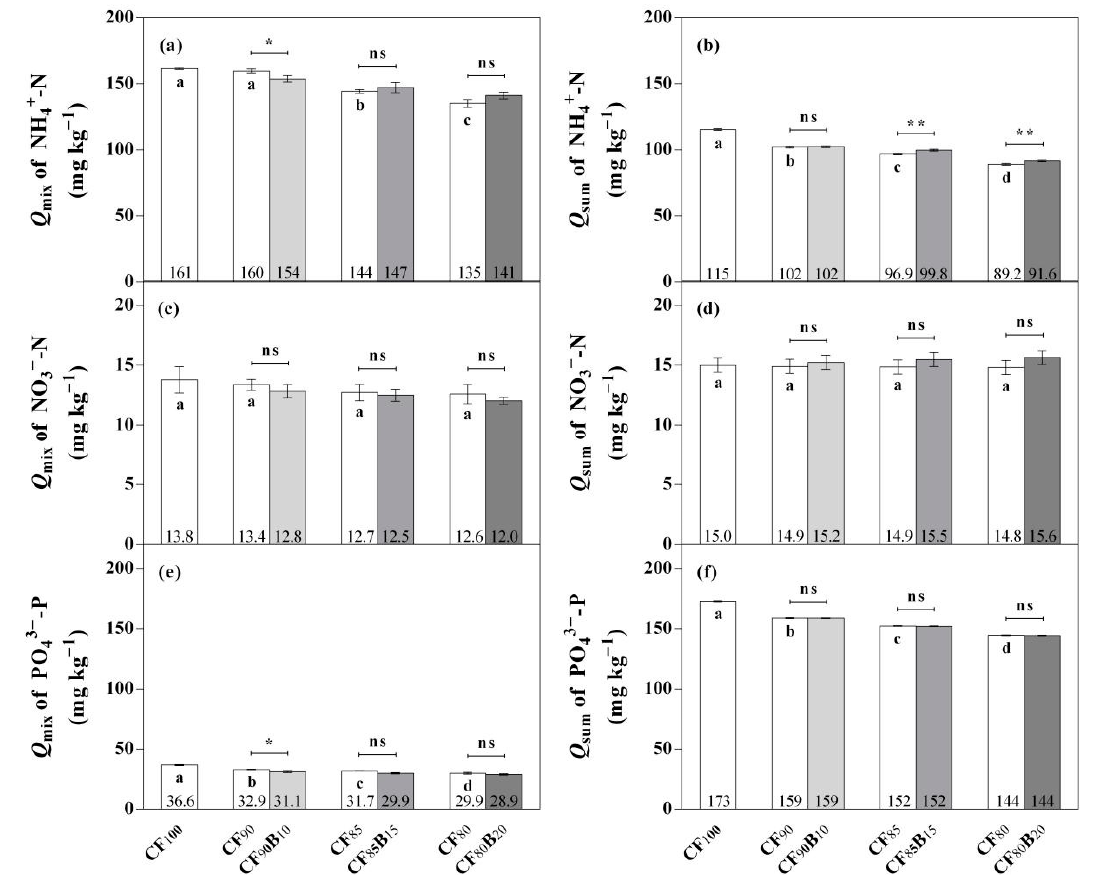
Figure 4. Effects of palm silk biochar (PSB) amendment on the release of water-soluble NH 4+ -N ( a , b ), NO 3 − -N ( c , d ), and PO 43 − -P ( e , f ) in soil with chemical fertilizer addition after 24 h equilibrium. Parameters: Q mix , NH 4+ -N, NO 3 − -N, or PO 43 − -P concentration in soil (including soil mixtures with compound fertilizer, calcium superphosphate, and/or PSB); Q sum , summation of NH 4+ -N, NO 3 − -N, or PO 43 − -P concentration in soil and other individual materials (including compound fertilizer, calcium superphosphate, and/or PSB). Treatments: CF 100 , 100% conventional fertilization; CF 90 , 90% conventional fertilization; CF 90 B 10 , 90% conventional fertilization plus 10% PSB-based fertilization; CF 85 , 85% conventional fertilization; CF 85 B 15 , 85% conventional fertilization plus 15% PSB-based fertilization; CF 80 , 80% conventional fertilization; CF 80 B 20 , 80% conventional fertilization plus 20% PSB-based fertilization. Data are expressed as means ± SD ( n = 3). For each parameter, bars labeled with different lowercase letters (e.g., a, b, c, etc.) indicate significant ( p < 0.05) differences among the rates of chemical fertilization alone based on the Tukey test. The asterisks indicate significant (*, p < 0.05) or highly significant (**, p < 0.01) differences, and ns indicates a non-significant ( α = 0.05) difference between the treatments of chemical fertilization with and without PSB amendment based on the Student’s t -test or Mann–Whitney U -test. Table 5. Effects of palm silk biochar (PSB) amendment on the release of water-soluble NH 4+ -N, NO 3 − - N, and PO 43 − -P in soil without chemical fertilizer addition after 24 h equilibrium.